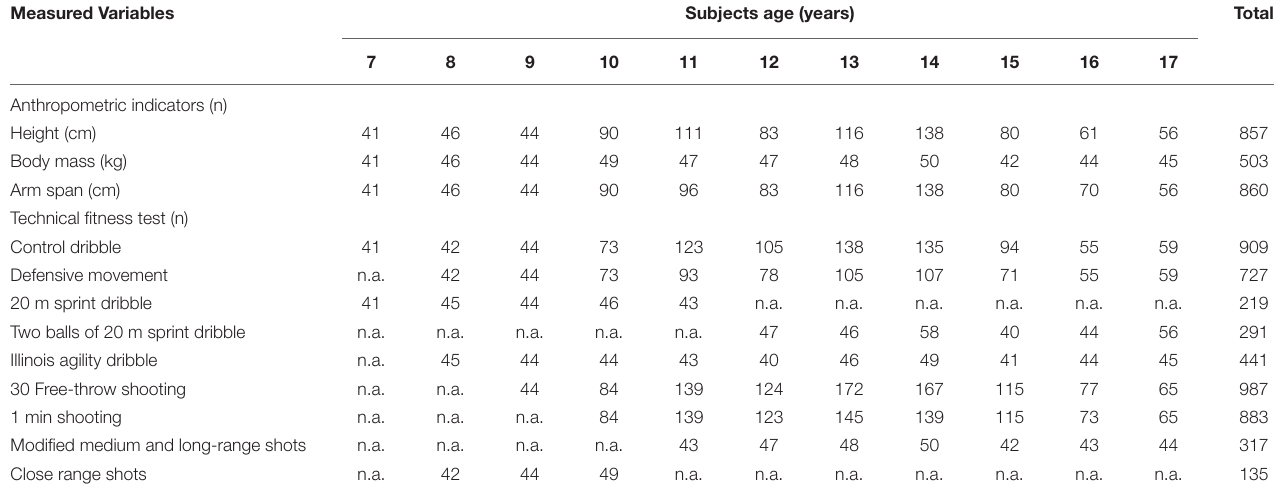
TABLE 2 | Number of subjects in youth basketball aged 7–17 years. Measured